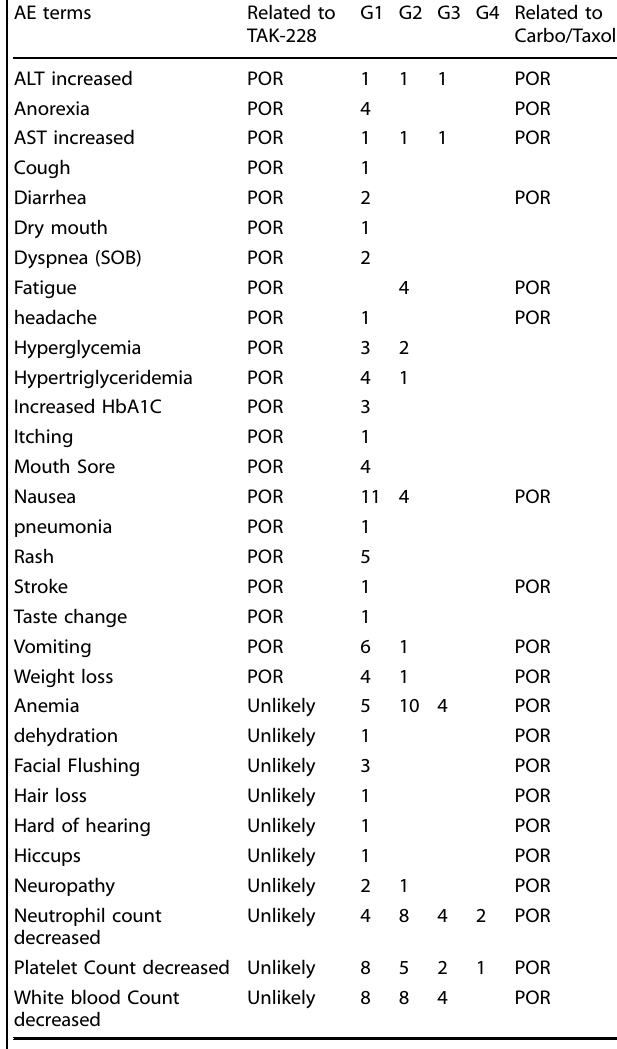
Table 2. Grade 3 – 4 TRAEs were seen at dose levels 2, 3 and 4 (Table 3). Treatment-related serious adverse events (SAEs) were seen in one patient under dose level 2. AEs leading to discontinuation of trial therapy occurred in 3 (16%) patients. AEs requiring a dose interruption and dose reduction occurred in 11 (58%) and 7 (37%) patients, respectively.